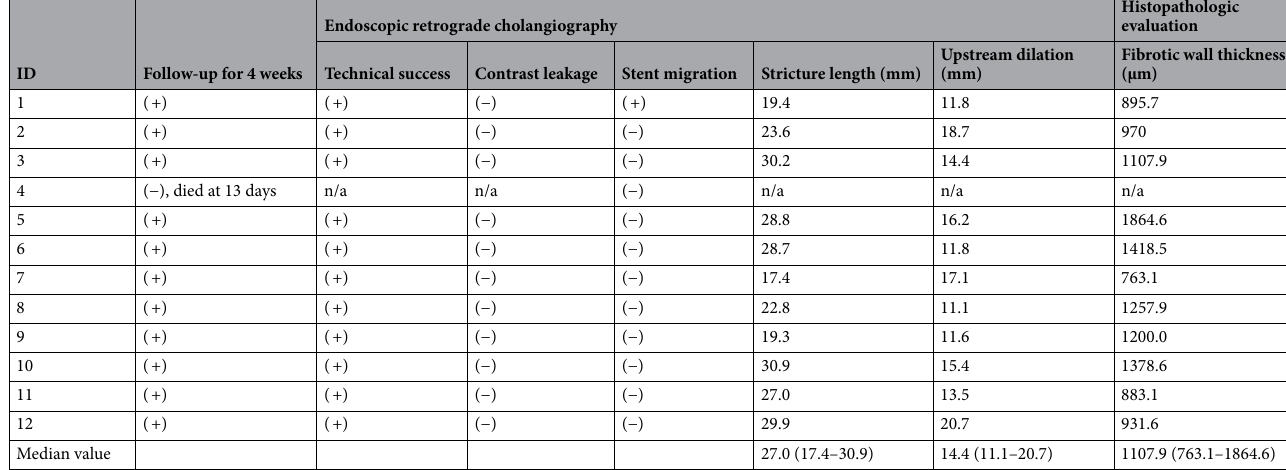
Table 3. Summary of the third step in-vivo animal study step. n/a, not applicable. * Circumference of the transverse axis at the widest upstream biliary dilation area.